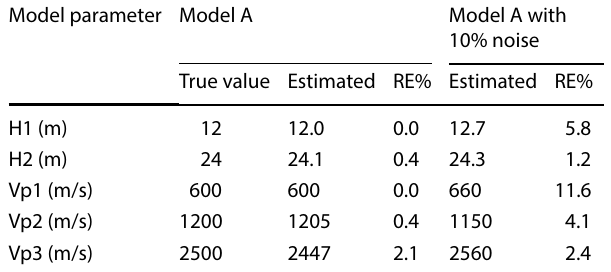
Table 2 The inversion of model A with and without noise Model parameter Model A